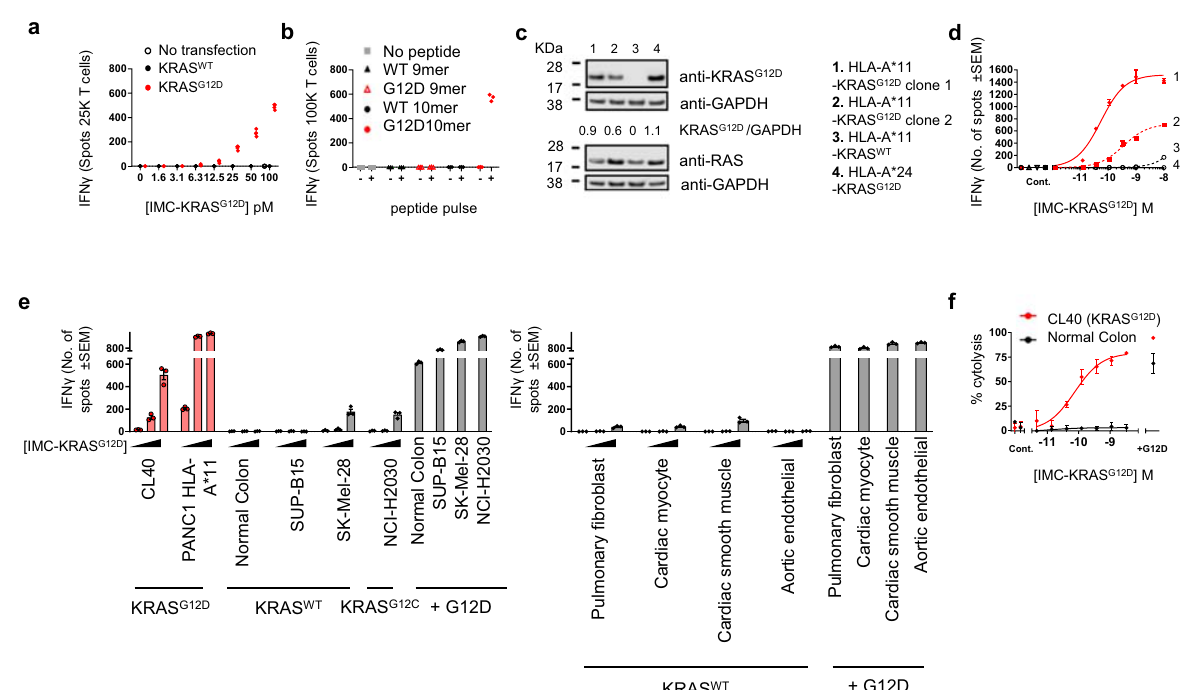
Fig.5|IMC-KRAS G12D mediatedTcellactivationandredirectedkillingofcancer cells expressing KRAS G12D , but not KRAS WT . a Immature dendritic cells differ- entiated from monocytes isolated from healthy donors were transfected with mRNAencodingKRAS WT orKRAS G12D or b pulsedwithindicatedexogenouspeptide, were treated with IMC-KRAS G12D and co-cultured with autologous T cellsfor24h. T cell activation was measured by IFN γ ELISPOT assay. Three biological replicates from one representative experiment from two independent experiments are shown. c Immunoblotand densitometryanalysisofisogenicPSN-1celllysates.Blot isrepresentativeoftwoindependentexperiments.Uncroppedblotscanbeviewed in Supplementary Fig.S10. d IFN γ ELISPOT output of cell lines modi fi ed to express HLA-A*11 and KRAS G12D (clones 1 & 2), HLA-A*11 and KRAS WT (clone 3) or only KRAS G12D (clone 4) treated with IMC-KRAS G12D and co-cultured with PBMC for 24h. Targetsalone,ornoIMC-KRAS G12D negativecontrols(Cont.)wereperformed.Mean data of three biological replicates ±SEM from one representative experiment from